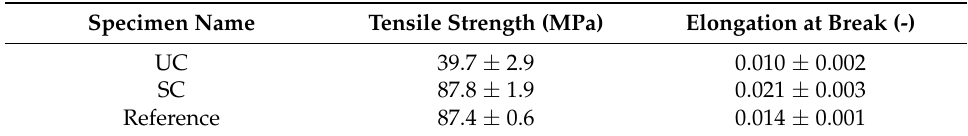
Table 13. Averaged tensile strengths and elongations at break of the tensile tests of samples with (SC) and without (UC) glass fiber sizing and reference samples.